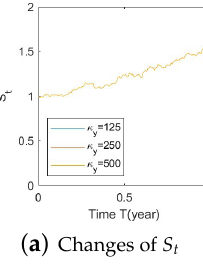
Figure A10. Cont